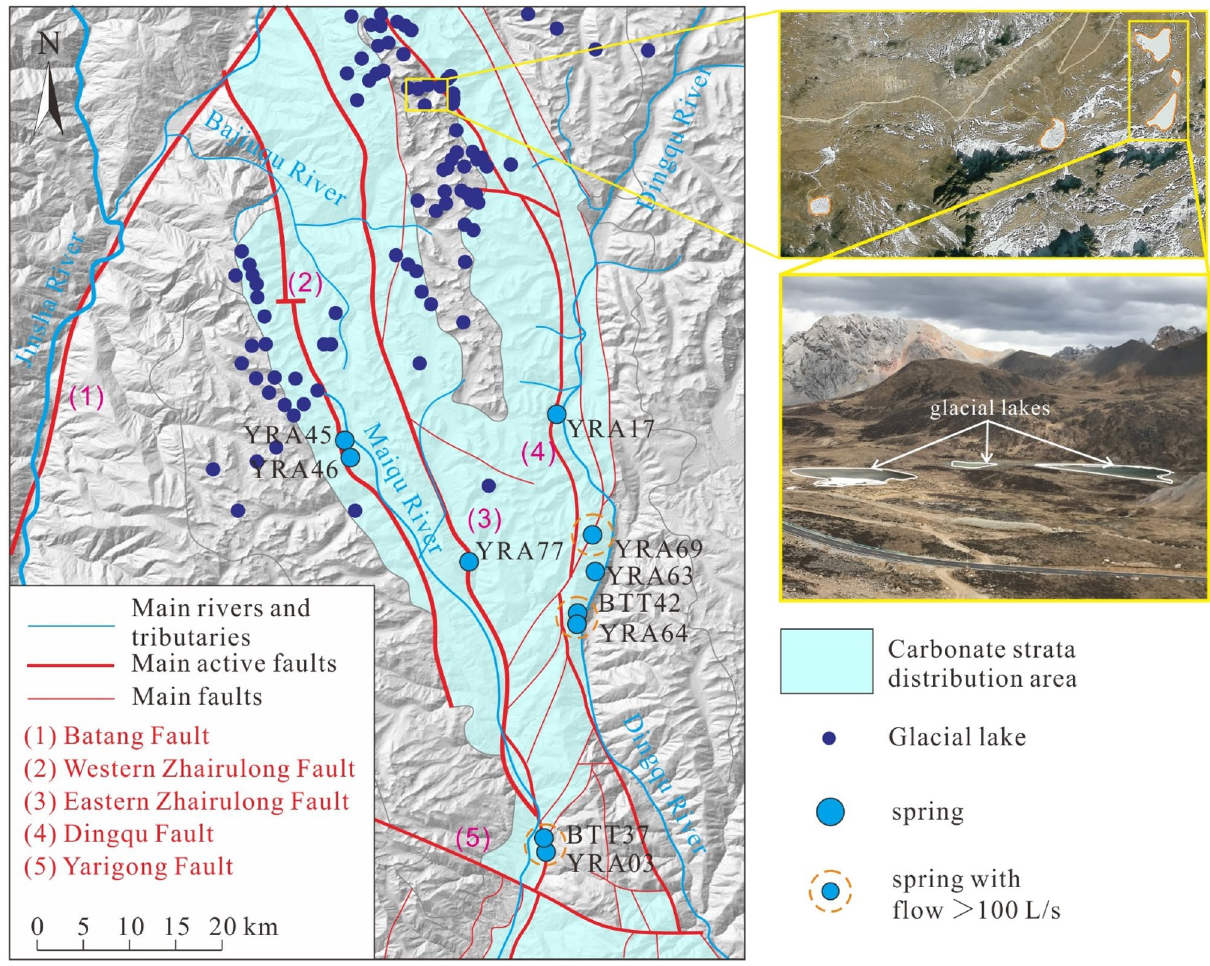
Figure 2. Distribution of glacial lakes in the study area. The digital elevation model rendering map background was derived from the Spatial Data Cloud (http:// www. gsclo ud. cn/) and generated using ArcGIS v 10.0. The figure was generated using CorelDRAW X6.